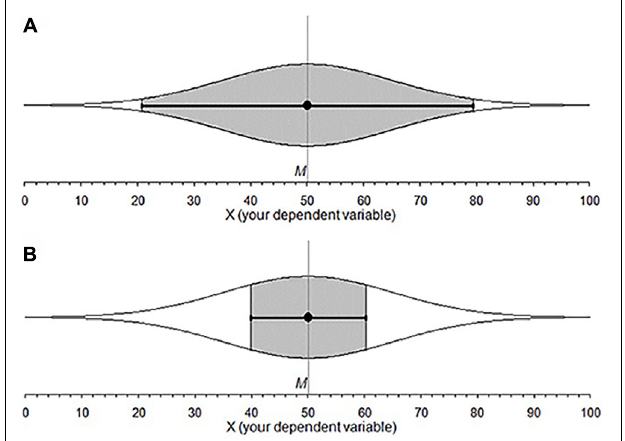
FIGURE 1 | Cat’s eye confidence intervals, points inside a CI are not equally likely to land on the µ . (A) 95% CI and shows 95% of the overall distribution. (B) A 50% CI for the same data: The gray area shows that much less of the overall distribution is accounted for.